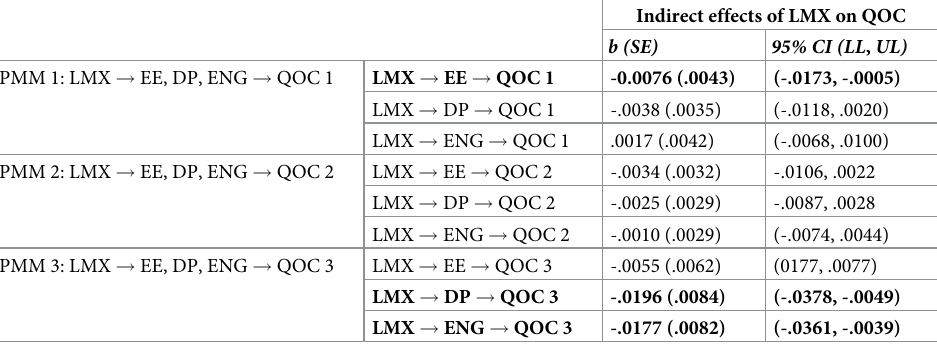
Table 2. Indirect effects for the paths on the parallel mediation models (PMMs).